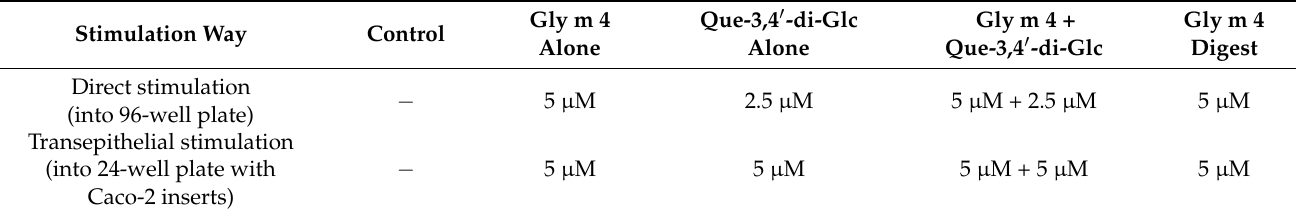
Table 1. Two stimulation ways, which were applied to each cell culture, except Caco-2 line (only direct stimulation because Caco-2 cells were on the